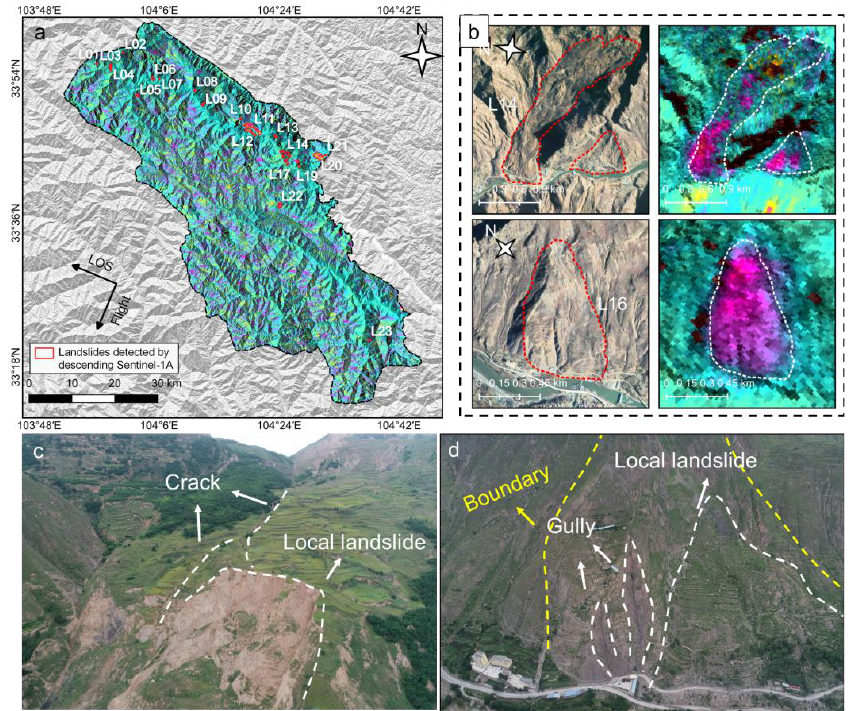
Figure 5. Stacking-InSAR landslide detection results based on descending data: ( a ) Stacking-InSAR phase results; ( b ) typical landslides; ( c ) distribution of cracks and local landslides of the L14 landslide; and ( d ) distribution of gullies and local landslides on the L16 landslide.